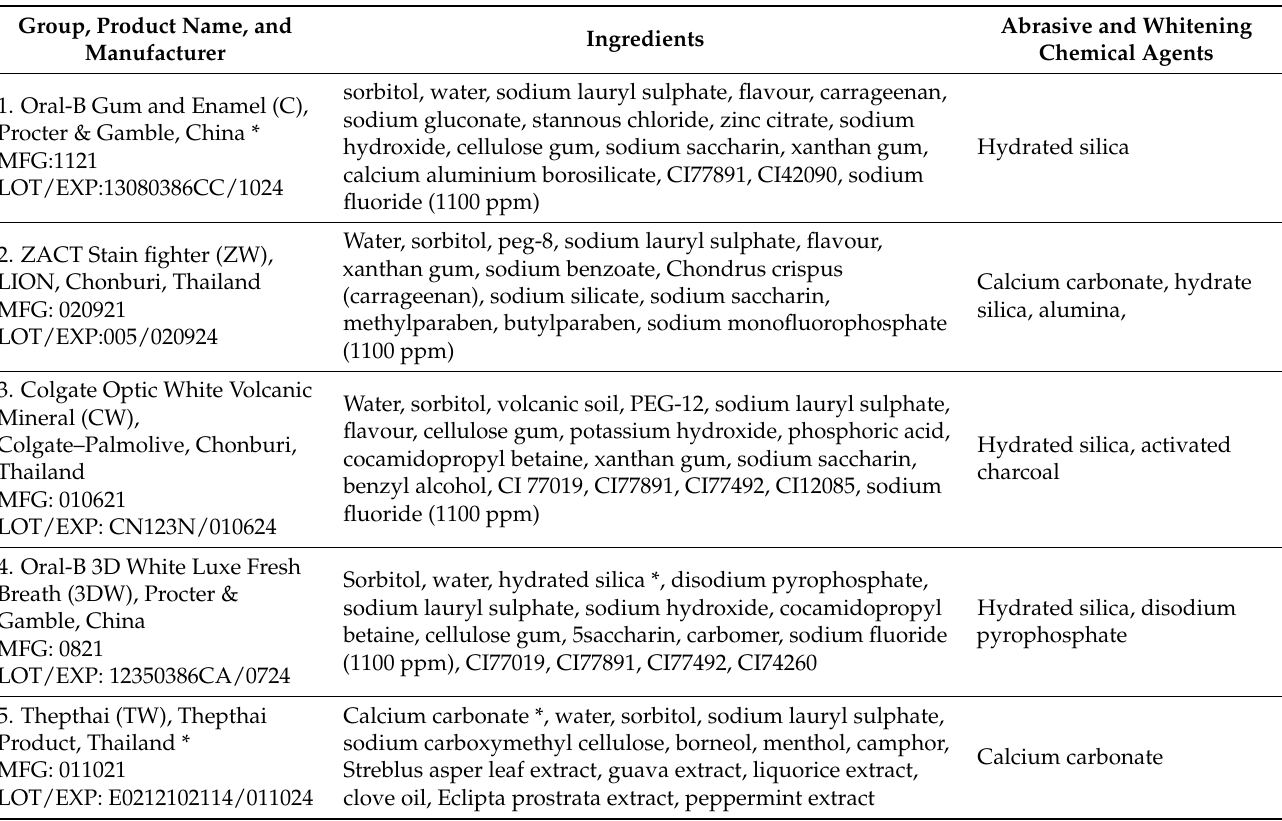
Table 1. Brand names, ingredients, manufacturers, abrasive agents, and whitening chemical agents (* conventional